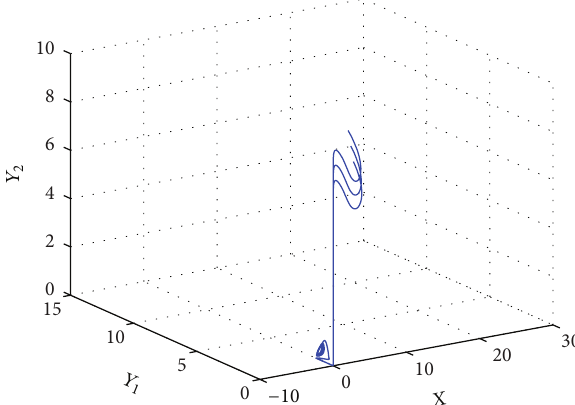
Figure 3: The global stability around the equilibriums 𝐸 ∗ of system